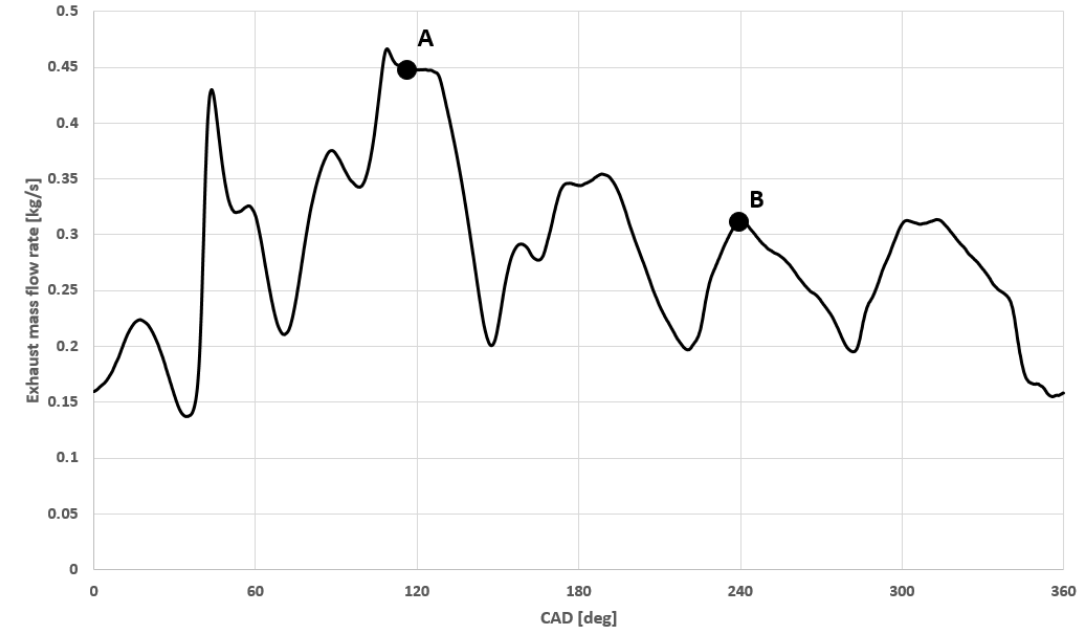
Figure 34. The mass-flow rate changes at the exhaust pipe with reference point A (peak mass flow rate) and B (low mass flow rate).